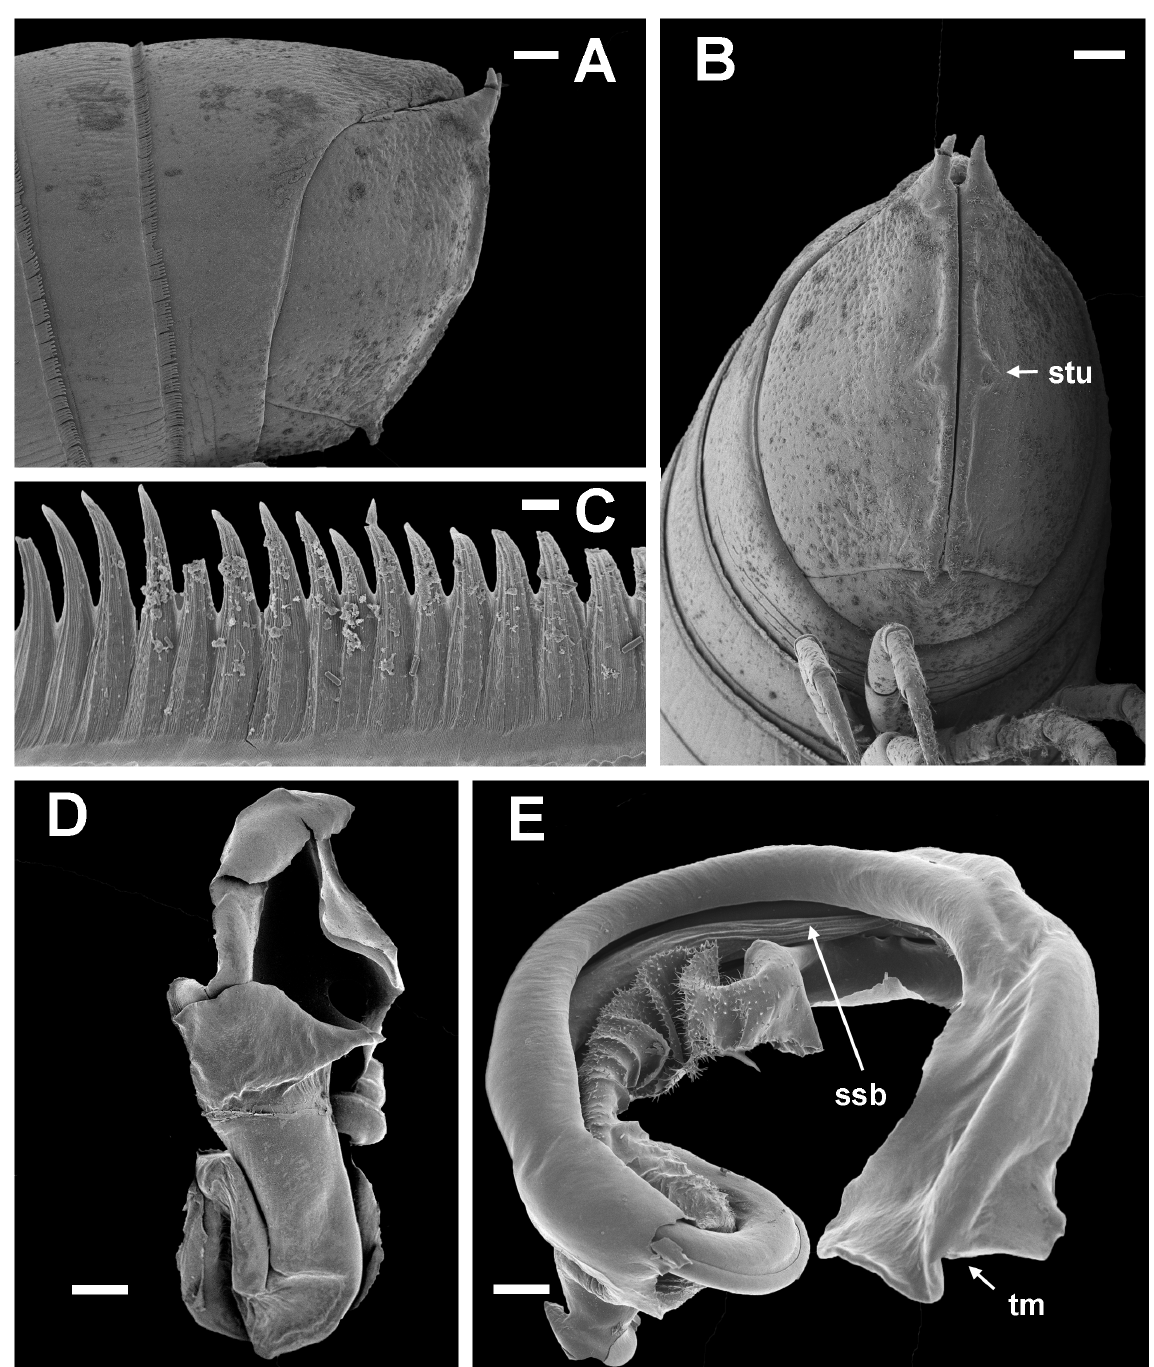
Fig. 8. Hoffmanides dissutus (Hoffman, 1963), ♂, from Udzungwa Mts National Park. A–B . Telson. A . Lateral view. B . Posterior view. C . Limbus. D . Gonopod coxa, anterior view. E . Gonopod telopodite, posterior-mesal view. Abbreviations: ssb = spine-like side branch of solenomere, nested in cavity of telomere; stu = middle setiferous tubercle on “ravelin”; tm = tip of telomere. Scale bars: A–B, D = 0.2 mm; C = 0.001 mm; E = 0.1